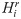
Immunoglobulin-like fold domain of CATH code 1svcP02, taken as an example to visualize to what extent the hydrophobicity of each amino acid (Hir) is influenced by the local hydrophobic interactions with surrounding residues (H˜ie).Individual amino acids on the X-axis are ordered according to the value of hydrophobicity in the hydrophobicity scale [34]. This illustrates the difference between hydrophobicity linked to the amino acid on its own and the one once it is included in the structure of a protein. All residues, including those classified as MIR, LIR, highly hydrophobic (H+2) or highly hydrophilic (H–2) are presented in forms of different markers. Dashed diagonal line defines observed hydrophobicity values equal to the hydrophobicity parameters from the scale.